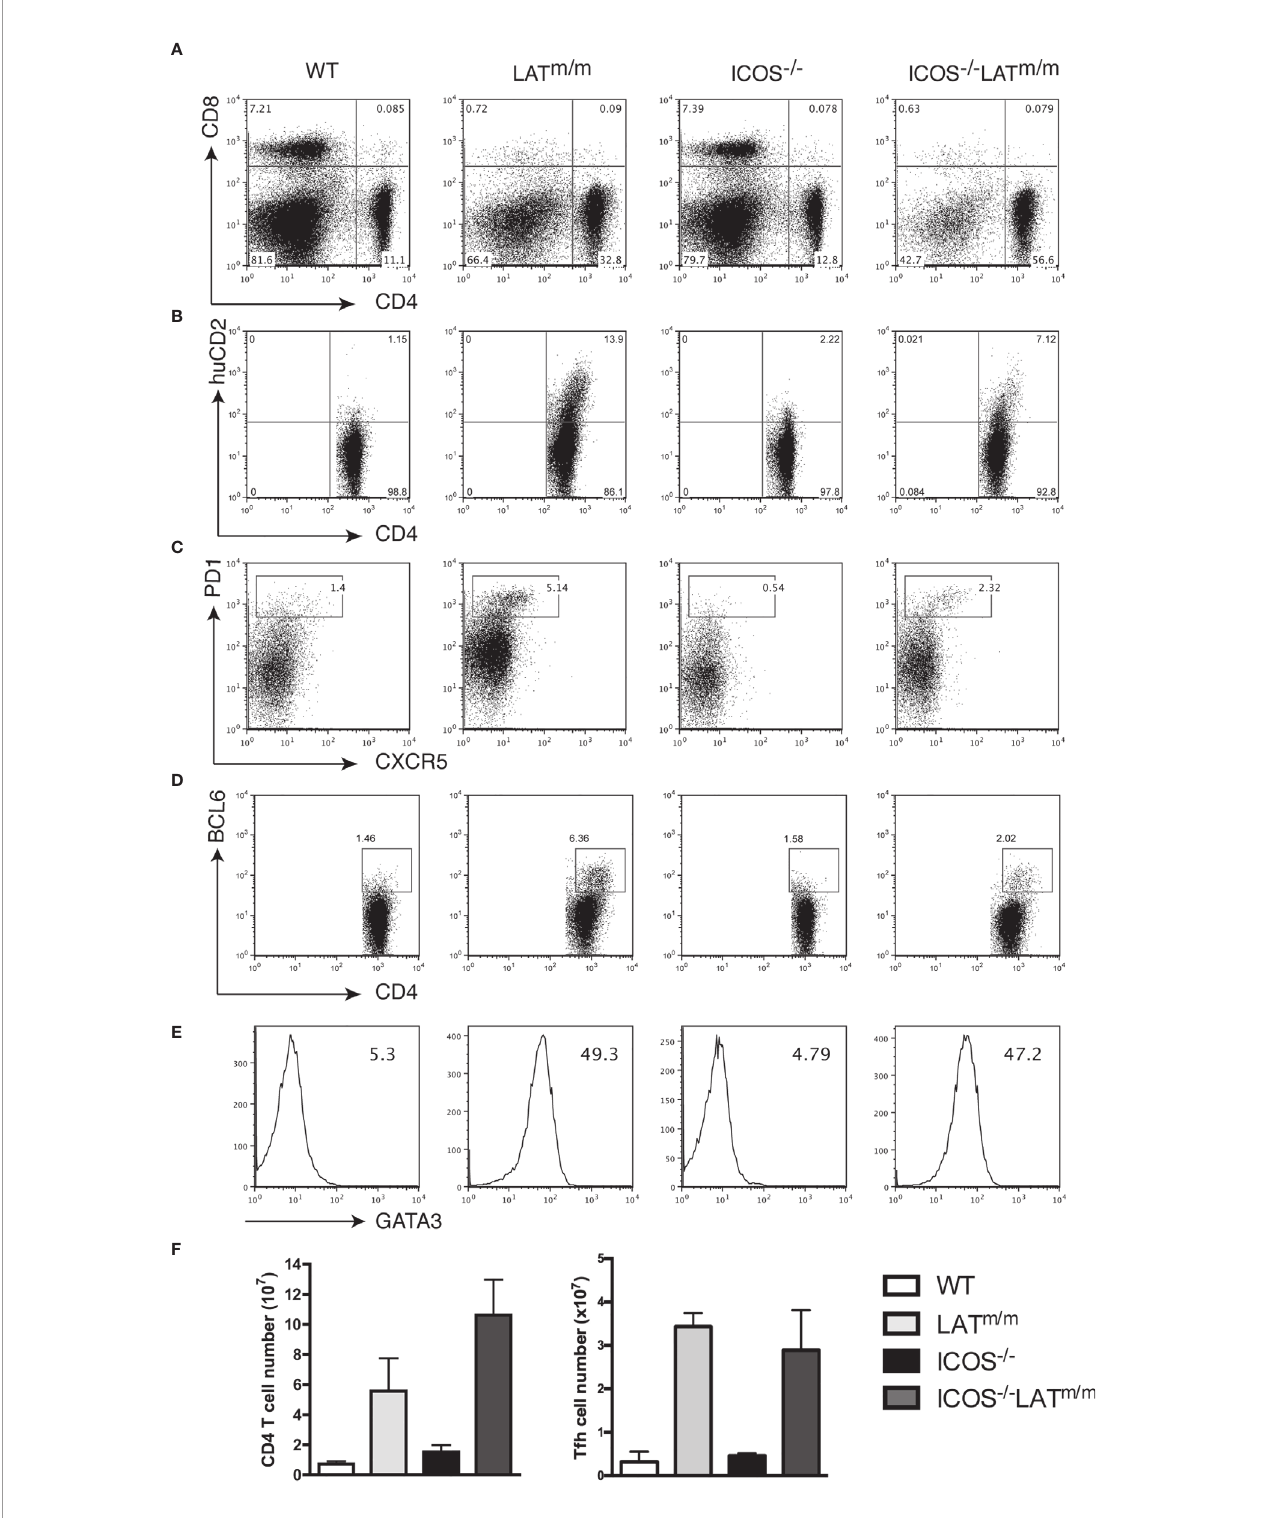
FIGURE 7 | ICOS signaling is not required for Tfh development in LATY136F mice. WT, LAT m/m , ICOS -/- , and ICOS -/- LAT m/m mice were all bred to IL4 KN2/+ mice and were analyzed at 6-8 weeks of age. (A) CD4 and CD8 expression on splenocytes. (B) Surface staining of CD4 and huCD2. (C) Surface expression of CXCR5 and PD1. (D) Intracellular staining of BCL6. (E) GATA3 levels and gMFI. Cells were pre-gated on CD4 + T cells (B – E) . (F) Absolute numbers of CD4 + T cells and CD4 + BCL6 + T cells. Data are representative of two individual